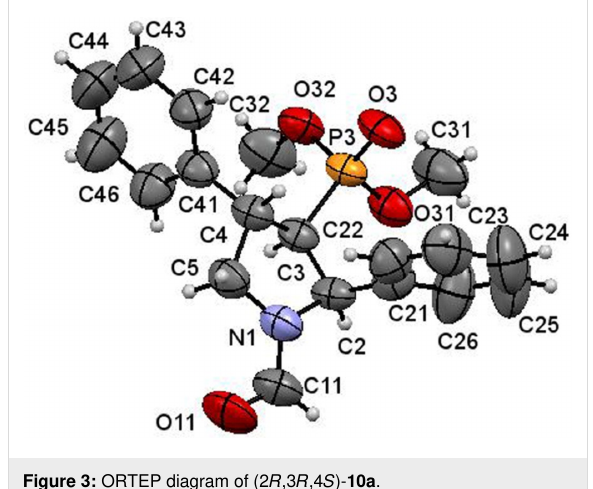
Figure 3: ORTEP diagram of (2 R ,3 R ,4 S )- 10a